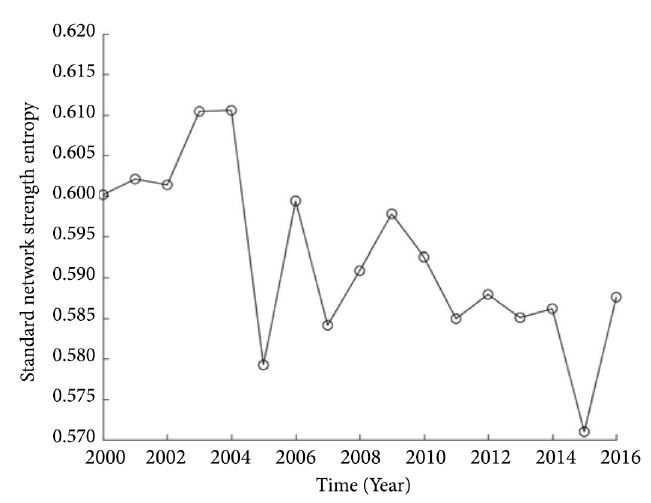
Figure 10. Standard network strength entropy change from 2000 to